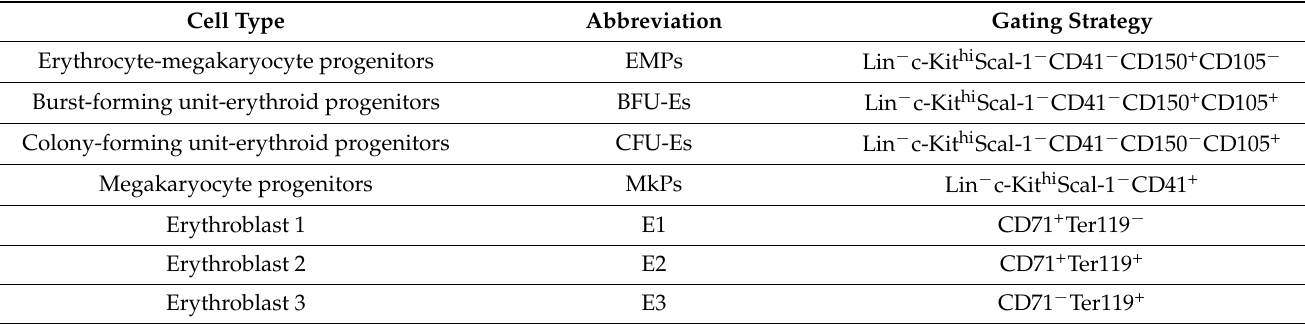
Table 1. Gating strategies and abbreviations for erythro- and megakaryocyte progenitors and erythroblasts. Cell Type Abbreviation Gating Strategy Erythrocyte-megakaryocyte